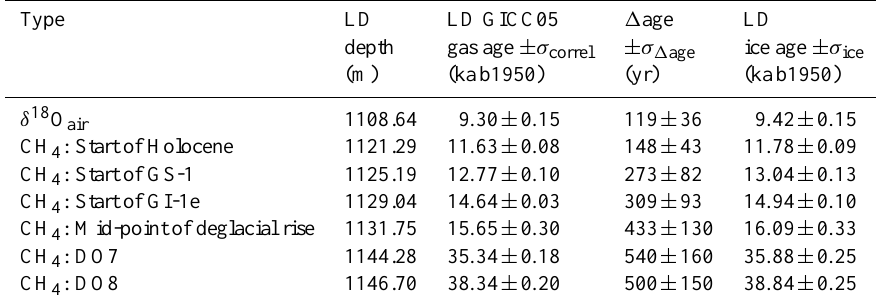
Table 2. LD age ties used in construction of the deglacial chronology and their uncertainties.